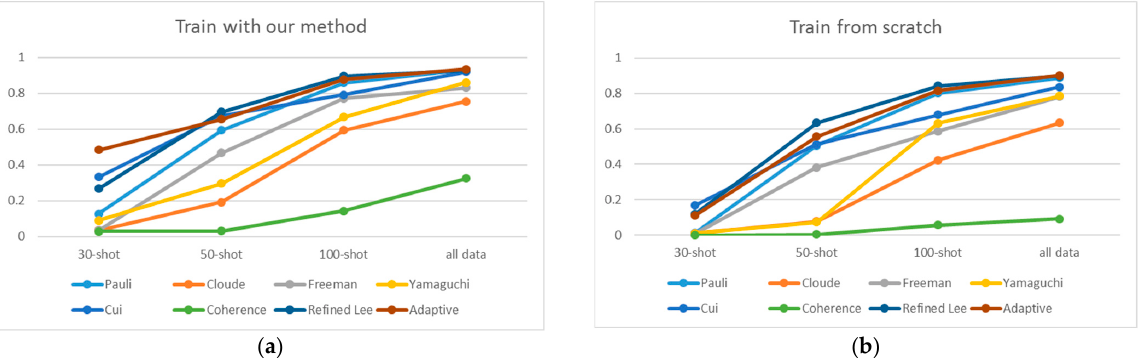
Figure 8. Ship detection results of different numbers of input samples: ( a ) train with our method; ( b ) train from